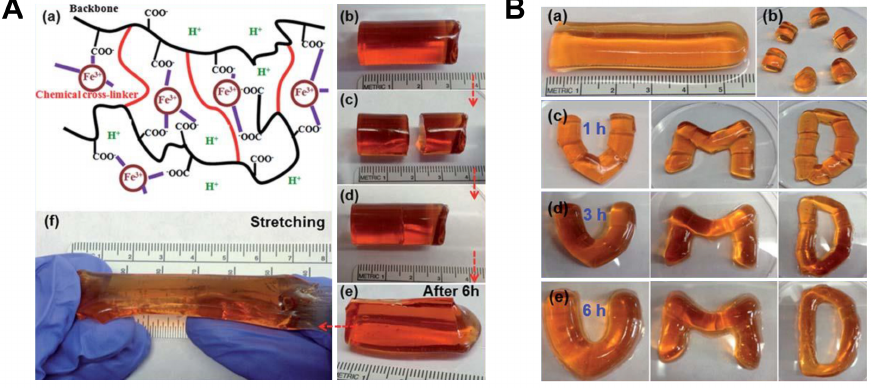
Figure 15. Self-healing poly(acrylic acid) (PAAc) hydrogels for potential biorobotic applications. ( A ) ( a ) Schematic illustration of the structure of the self-healing hydrogel. ( b – e ) Self-healing of a cylindrical hydrogel (Entry 3) at room temperature: ( b ) the original hydrogel, ( c ) the hydrogel after being cut, ( d ) the hydrogel after the two parts were brought into contact with each other, ( e ) the hydrogel after healing for 6 h. ( f ) Stretching the self-healed hydrogel up to 200%. ( B ) The use of the self-healing nature of the hydrogel to produce complex architectures. ( a ) The original hydrogel. ( b ) The hydrogel after being cut. ( c–e ) The hydrogel segments arranged in the form of letters: U, M, and D, after ( c ) 1, ( d ) 3, and ( e ) 6 h of self-healing. Reproduced with permission from [337]. Copyright 2013, The Royal Society of